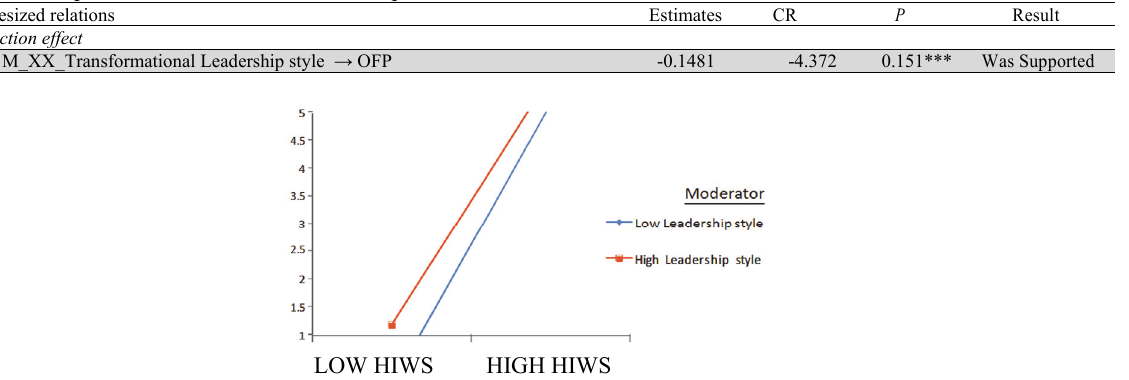
Fig. 3. transformational leadership style